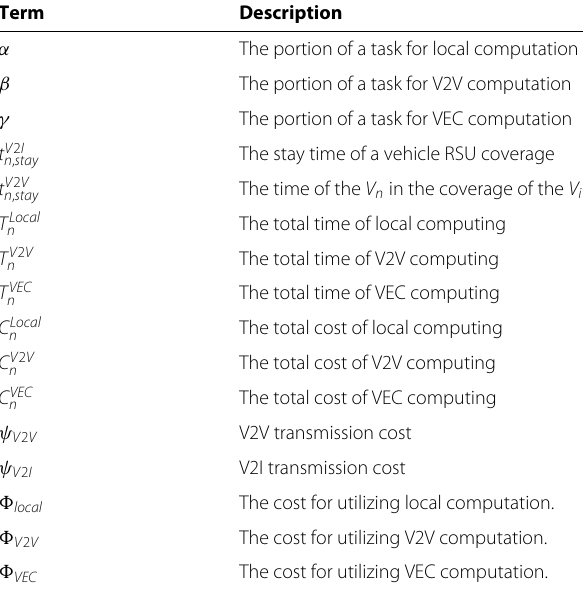
Table 1 Frequently Used